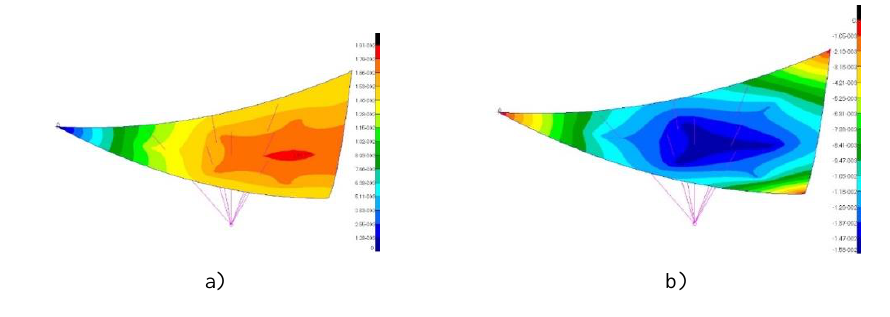
Fig. 22. Distribution of knitted mesh fabric points displacements: a) distribution of magnitude of displacement vector |𝐮| ,